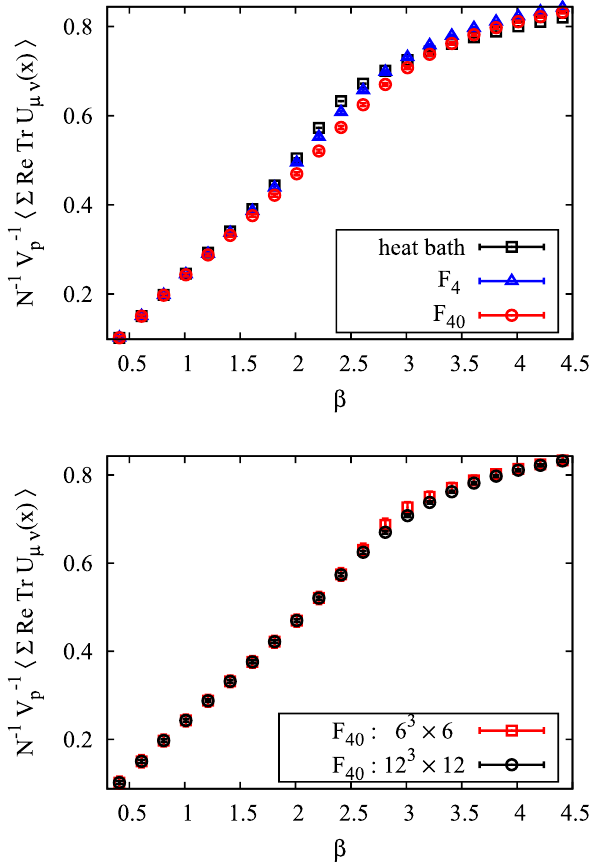
Fig. 6 Mean value of the plaquette from simulations using the algo- rithm and the heat bath algorithm. Top panel: comparison of the per- formance of the two local updates. Lower panel: finite volume effects when using the the present